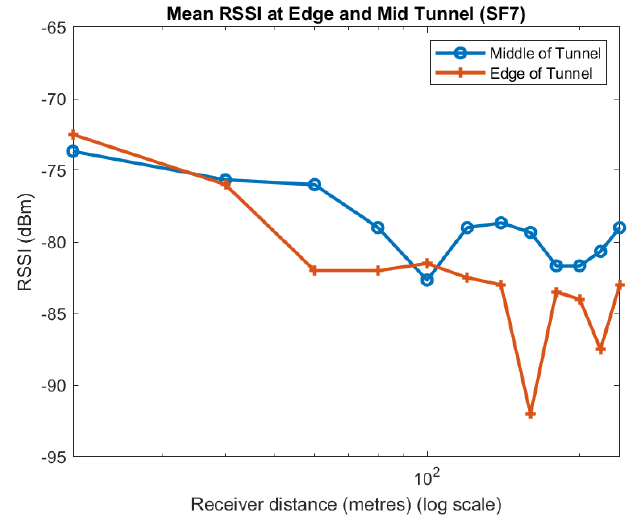
Figure 9. Effect of position in tunnel on RSSI: SF7.